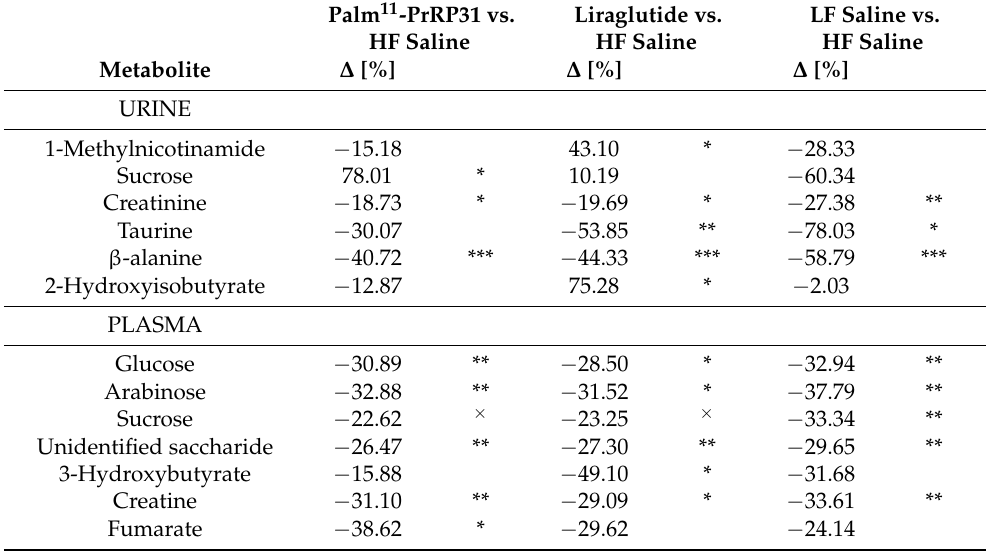
Table 4. Urinary and serum metabolites significantly changed in WKY HF palm 11 -PrRP31, WKY HF liraglutide and WKY LF saline compared to WKY HF saline at the end of the experiment (66 weeks of